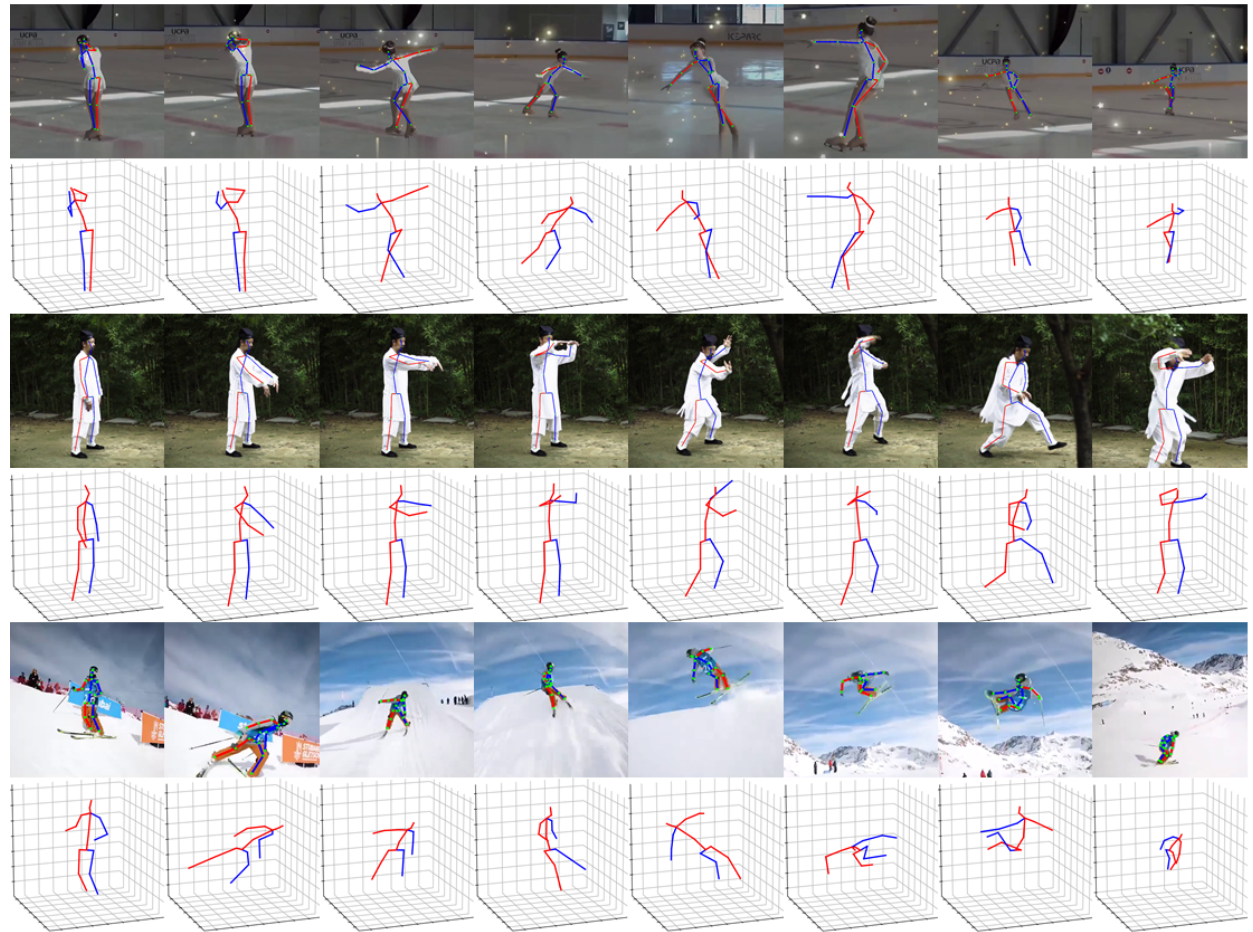
Figure 7. Visualization results of the proposed STFormer for reconstructing 3D human poses on challenging natural scene